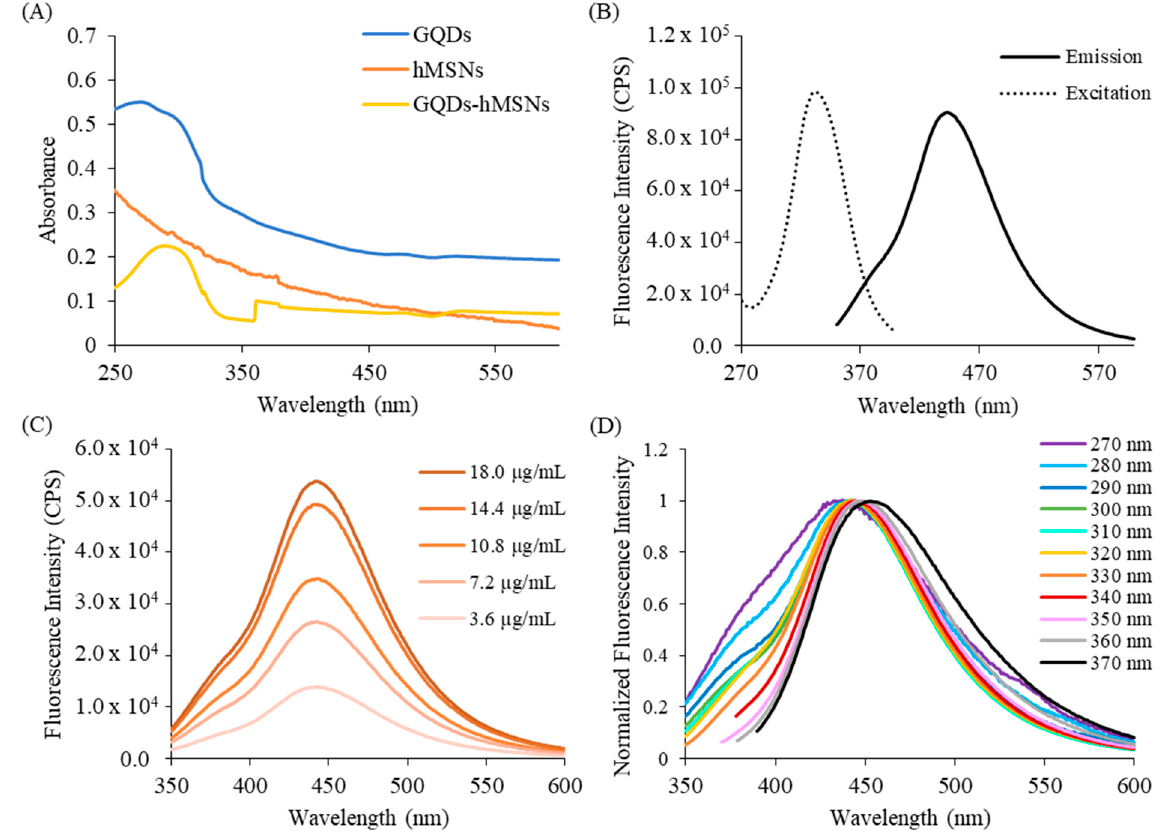
Figure 5. ( A ) Absorption spectra of GQDs (100 µg/mL), hMSNs (10 µg/mL), and GQDs-hMSNs (10.8 µg/mL). ( B ) Excitation and emission spectrum of GQDs-hMSNs (10.8 µg/mL). ( C ) Concentration dependency of GQDs-hMSNs. ( D ) Changing excitation of GQDs-hMSNs (18 µg/mL).